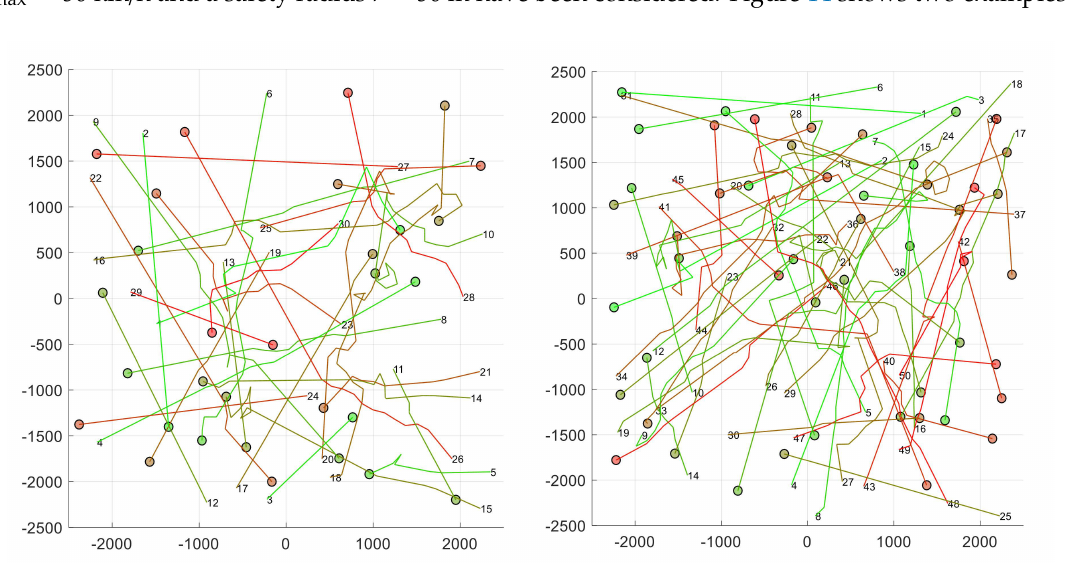
Figure 14. Random scenarios with 30 (left) and 50 (right) UAVs applying BBCA. Numbers in the plots represent initial UAV positions; circles represent current UAV positions and the established safety radius; each line represents a UAV trajectory (from the initial to the final